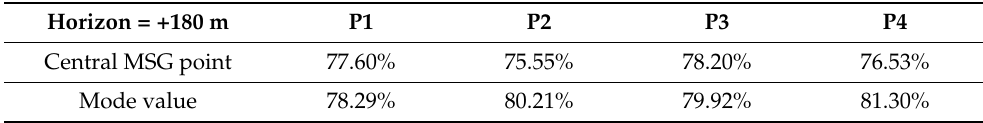
Figure A2. ( a ) bar plots regarding the amount of clear and cloudy which maintained their condition after 180 min; ( b ) temporal variation of the clear persistent cases (lines labelled with p) and of those that changed their status after 180 min (labelled with n). Table A1. Percentage of cases that does not change their CT typology after 180 min for the four PV plants, using the central MSG point or the modal value in the box of 3 × 3